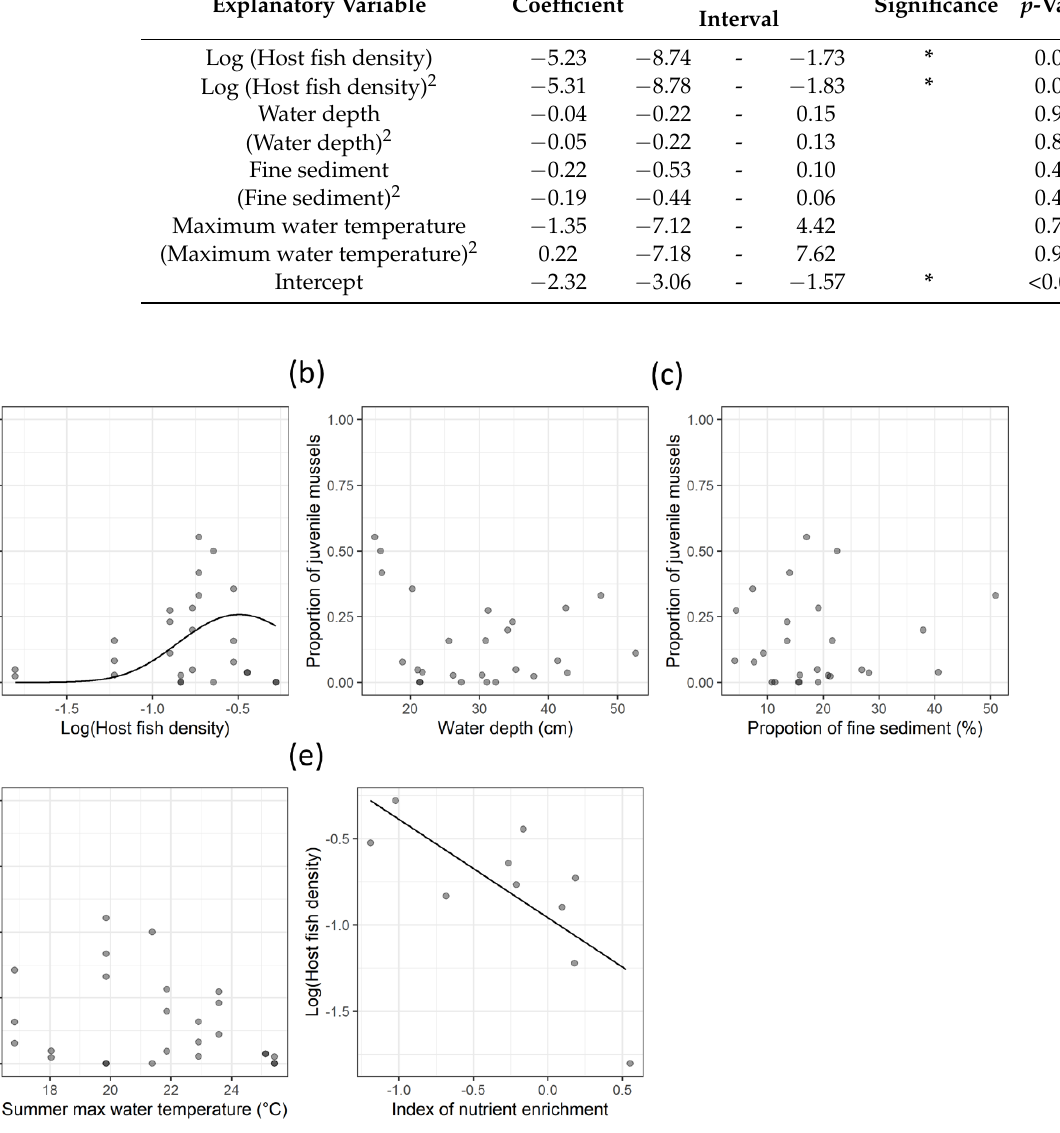
Figure 3. Relationships between the proportions of juvenile mussels and investigated factors: host fish density, water depth, proportion of fine sediment and summer maximum water temperature ( a – d ), and the relationship between host fish density and index of nutrient enrichment ( e ). The points represent the observed values. The solid line represents the predicted values (Table 1, Table S5). Table 1. Results of the averaged models examining the relative effects of factors affecting the re- cruitment success of M. laevis . Significant results according to the significance test ( α = 0.05) are indicated with an asterisk.